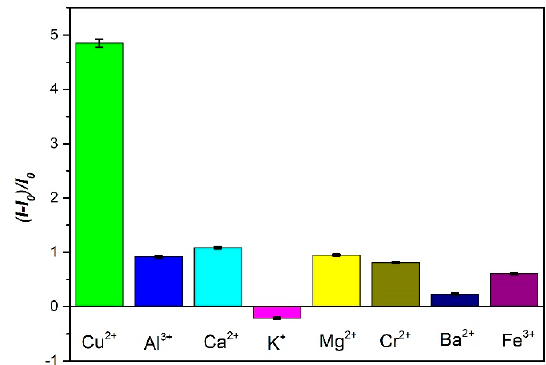
Figure 4. The selectivity of Cu 2+ analysis using the GO-dsDNA-CdTe QD’s sensor.